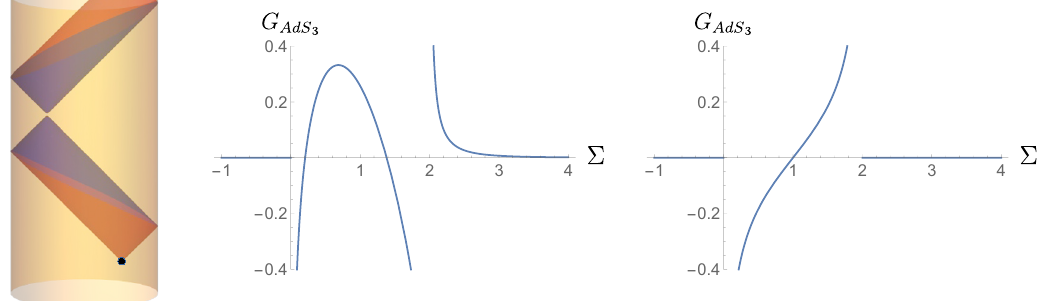
Figure 2 . Retarded propagation in AdS 3 with Dirichlet boundary conditions. On the left, we show the wavefront of a point source (surface of singularity of the retarded Green function), which \bounces" o(cid:11) the boundary. The wavefront is described by (cid:6) = 0 (orange) and (cid:6) = 2 (blue). On the right, we show the behavior of the retarded green function as a function of (cid:6). Two